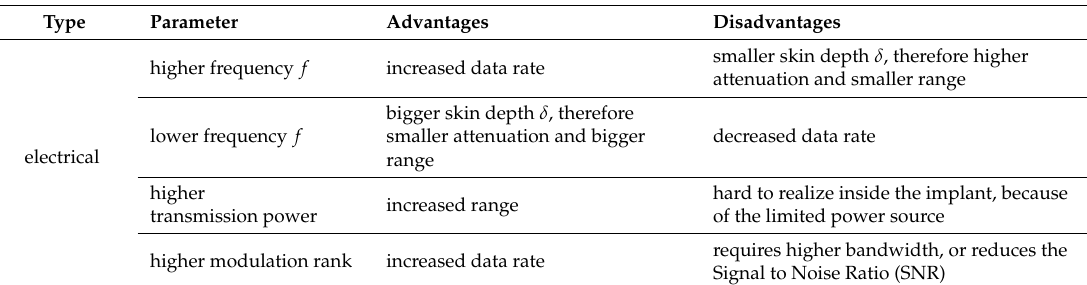
Table 1. Discussion of advantages and disadvantages of different parameters for titanium encapsulated implantable devices with inductive data and power